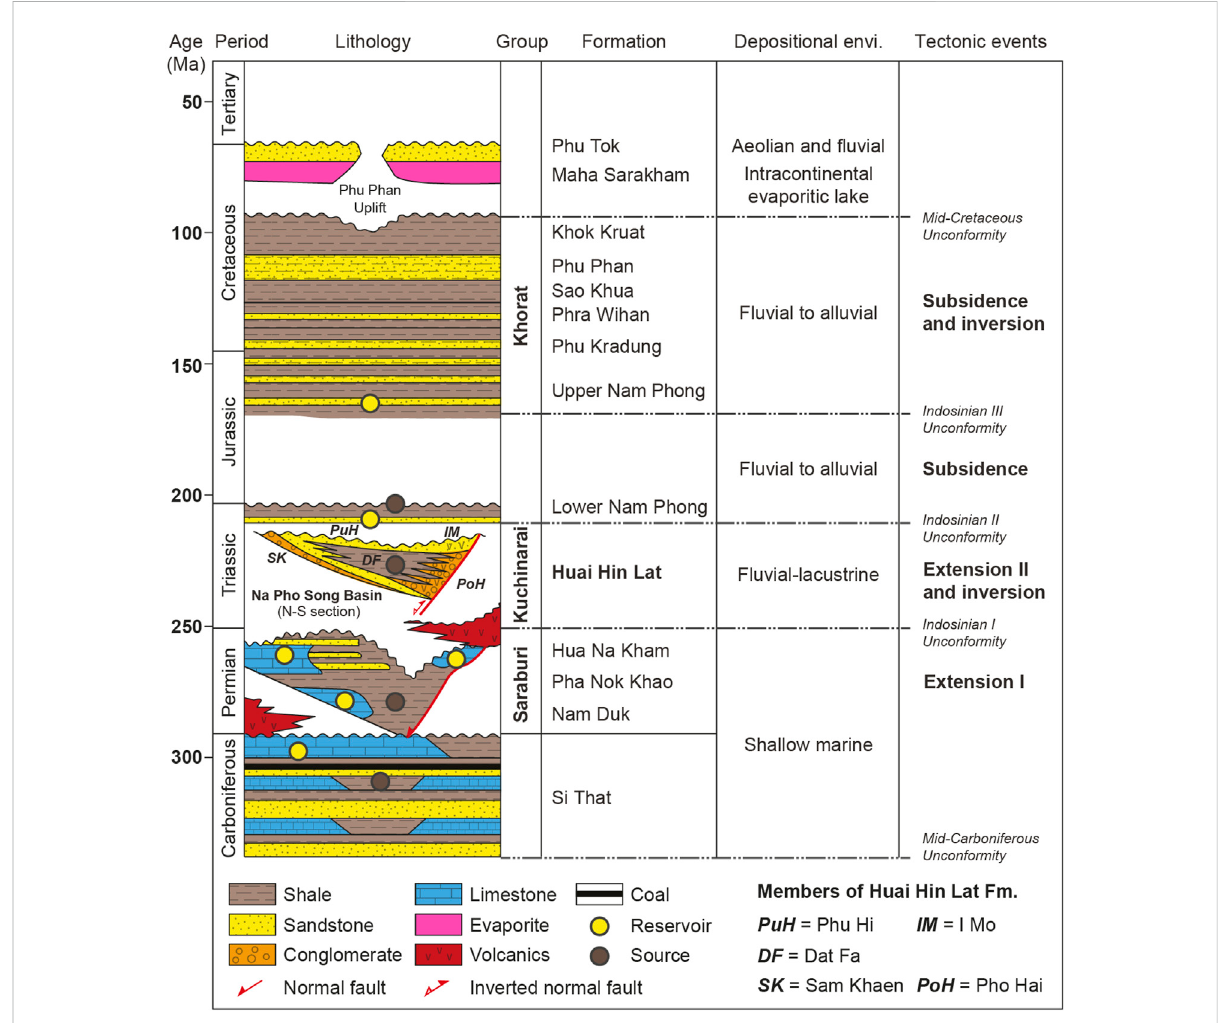
FIGURE 2 Stratigraphy of the Khorat Plateau including petroleum system elements and key events (modi fi ed from Racey,